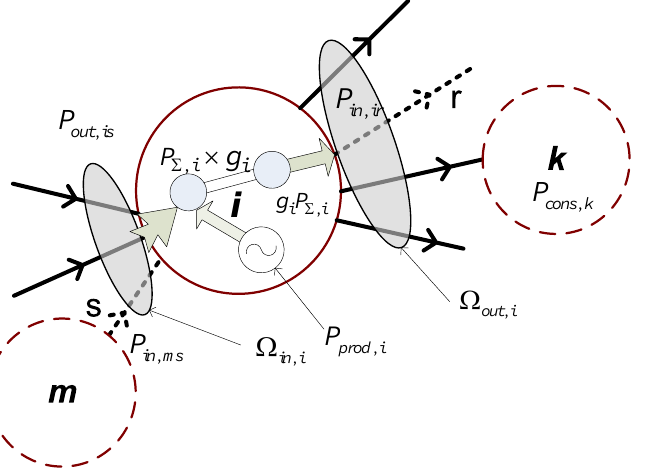
i r Figure 1. The products of network line [64], (p. 209). The line r , which receives physical flow from node k and outputs it to node i , is asso- ciated with the production activity of the line, in which the model product, the output flow of node k